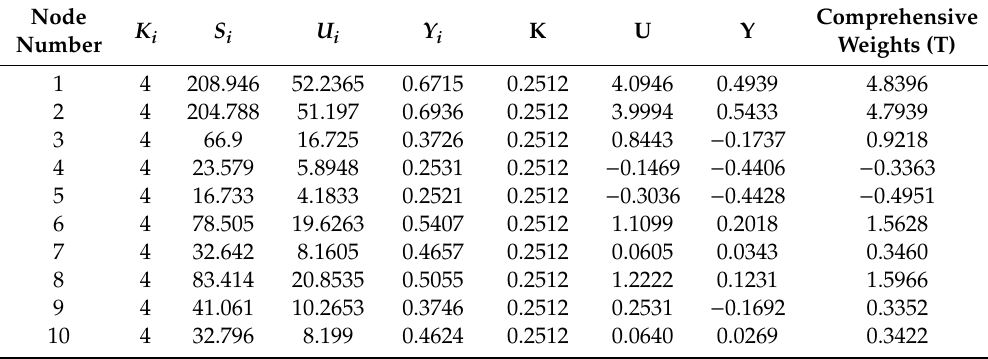
Table 9. Structural characteristics and comprehensive weights of the highway network.